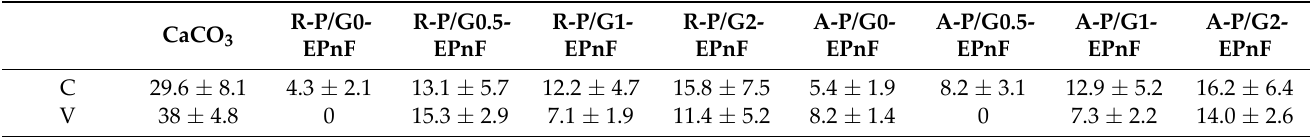
Figure 7. SEM images of CaCO 3 obtained through GD crystallization assays on a glass substrate (control substrate). Magnifications of ( a ) 200 × , ( b ) 2500 × , ( c ) 7000 × , and ( d ) 100,000 × . Table 2. Crystal sizes of calcite (C) and vaterite (V) obtained in GD crystallization assays on